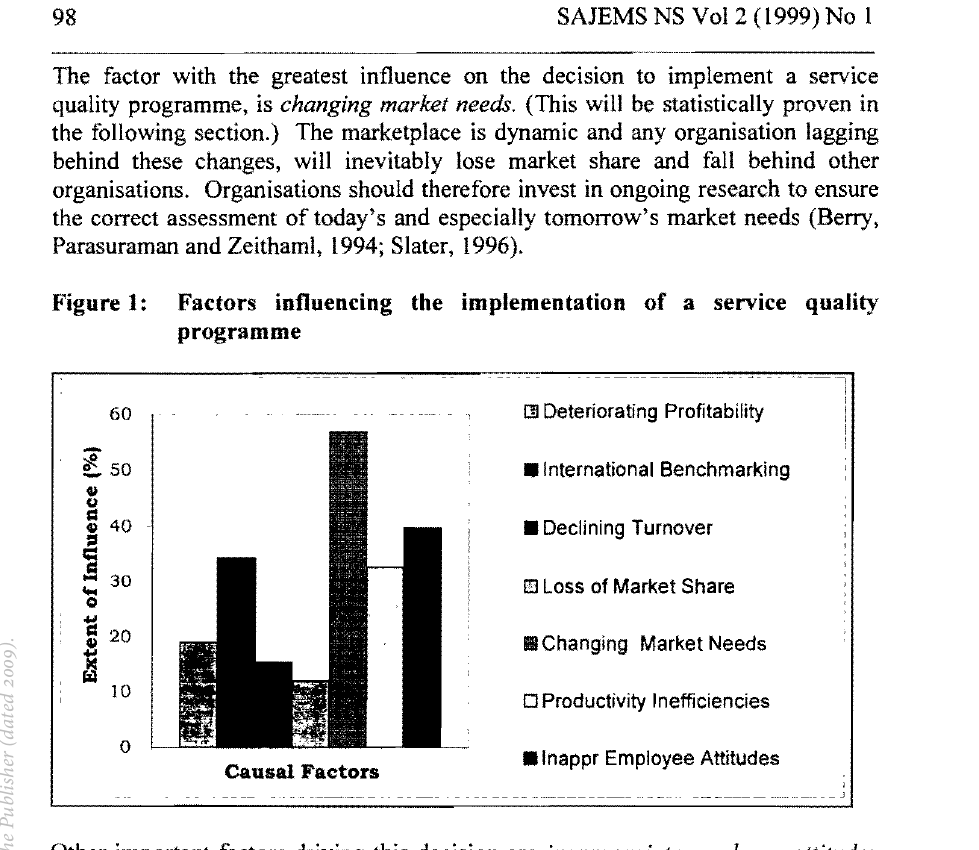
Factors influencing the implementation of a service